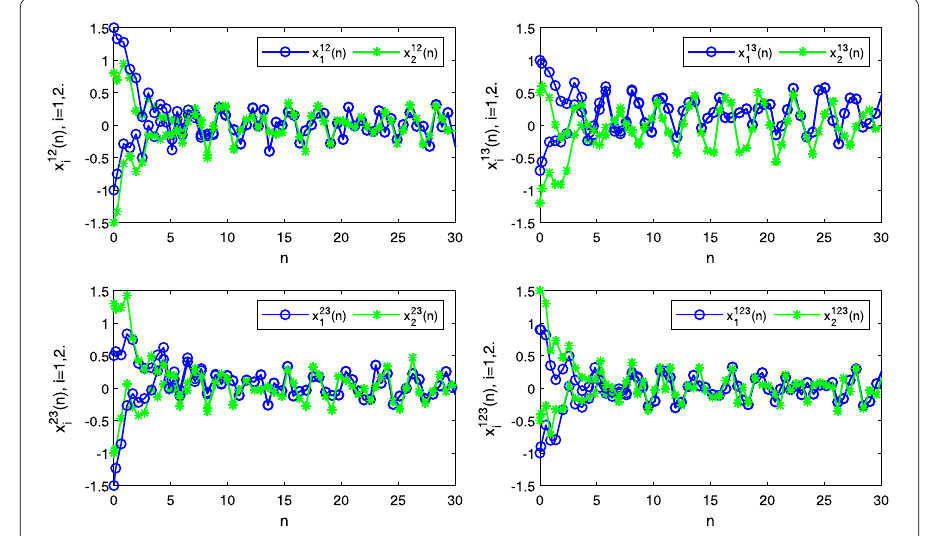
Figure 7 T = Z . Transient states of x 12 ( n ), x 13 ( n ), x 23 ( n ), and x 123 ( n )